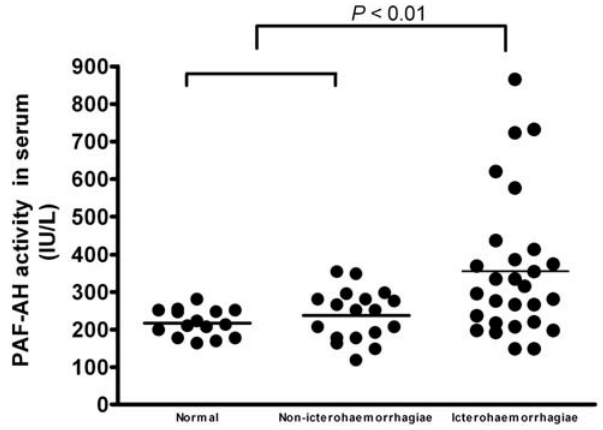
Figure 5. PAF-AH levels in serum of patients with leptospirosis and healthy adult individuals. Normal (n=15), healthy human group; non-icterohaemorrhagiae (n=18), leptospirosis patients infected by L. interrogans serogroup Pyrogenes (n=3), Autumnalis (n=3), Pomona (n=3), Hebdomadis (n=4) and Canicola (n=5), other than L. interrogans serogroup Icterohaemorrhagiae; icterohaemorrhagiae (n=28), leptospirosis patients infected by L. interrogans serogroup Icterohaemorrhagiae. Horizontal bars represented the mean value for each group.